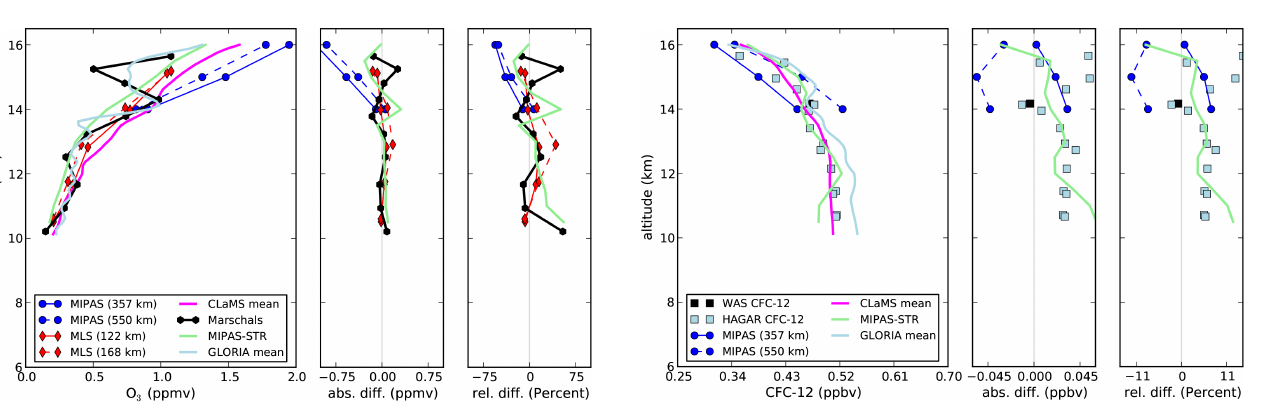
Figure 13. Comparison of O 3 abundance between GLORIA dynamics-mode measurements and various collocated data sets.